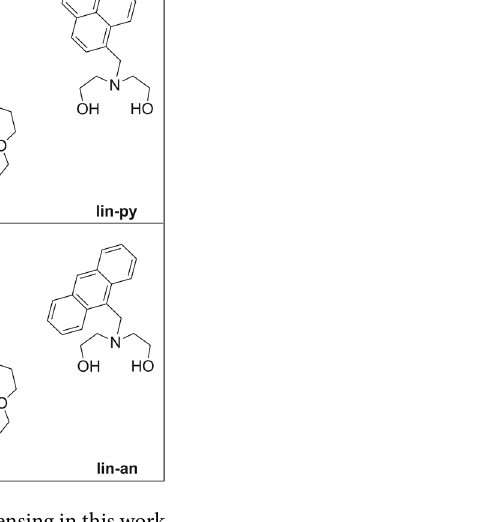
Figure 2. Molecules developed for dry barium sensing in this